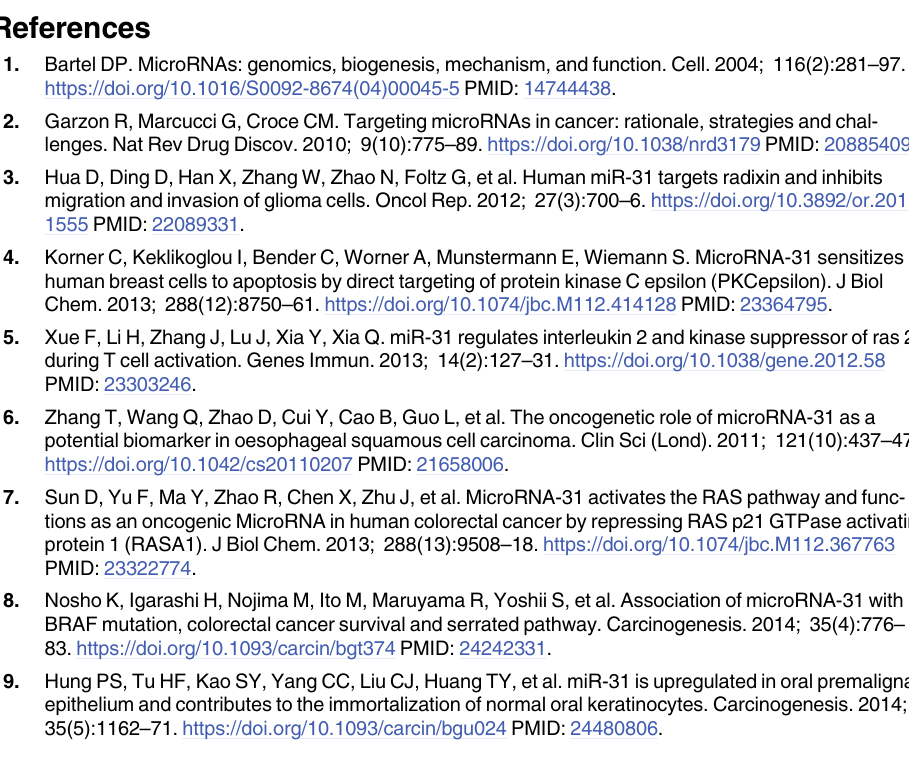
qRT-PCR. miRNA expression levels were normalized against RNU6B . Values shown are rela- tive to miR-31 expression